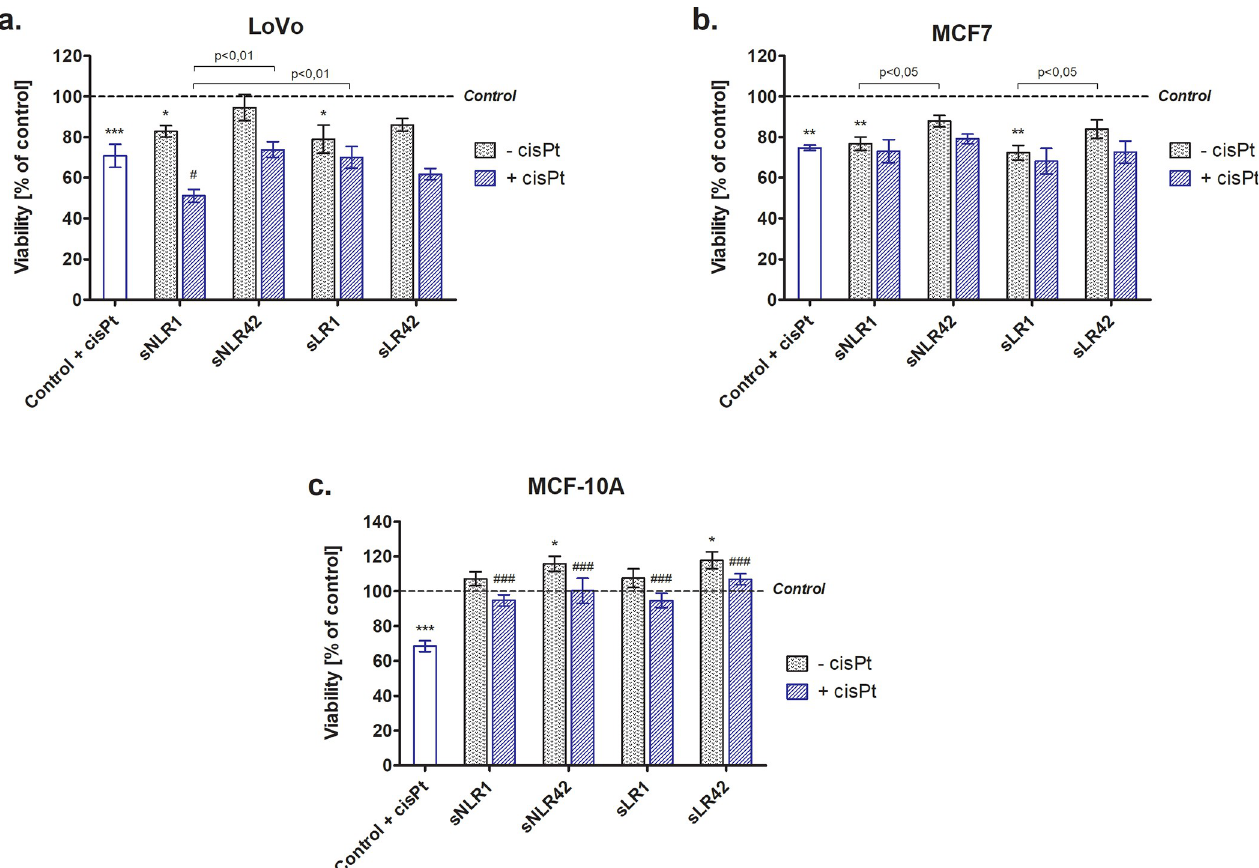
Fig 1. Viability of LoVo (panel a), MCF7 (panel b), and MCF-10A (panel c) cells after incubation (24 h) with the PRBC supernatants (5%) in the absence or presence of cisPt (panel a and b: 25 μ M; panel c: 40 μ M) evaluated using the CCK-8 assay. All data is presented as a percentage of control (untreated cells— assumed as 100%). Error bars denote ± SD, n = 15 (3 independent experiments, each performed with supernatants of PRBCs derived from five donors); � /# p < 0.05; ��� /### p < 0.001 compared to the appropriate control, � p < 0.05; �� p < 0.01; ��� p < 0.001 vs. control (untreated cells).